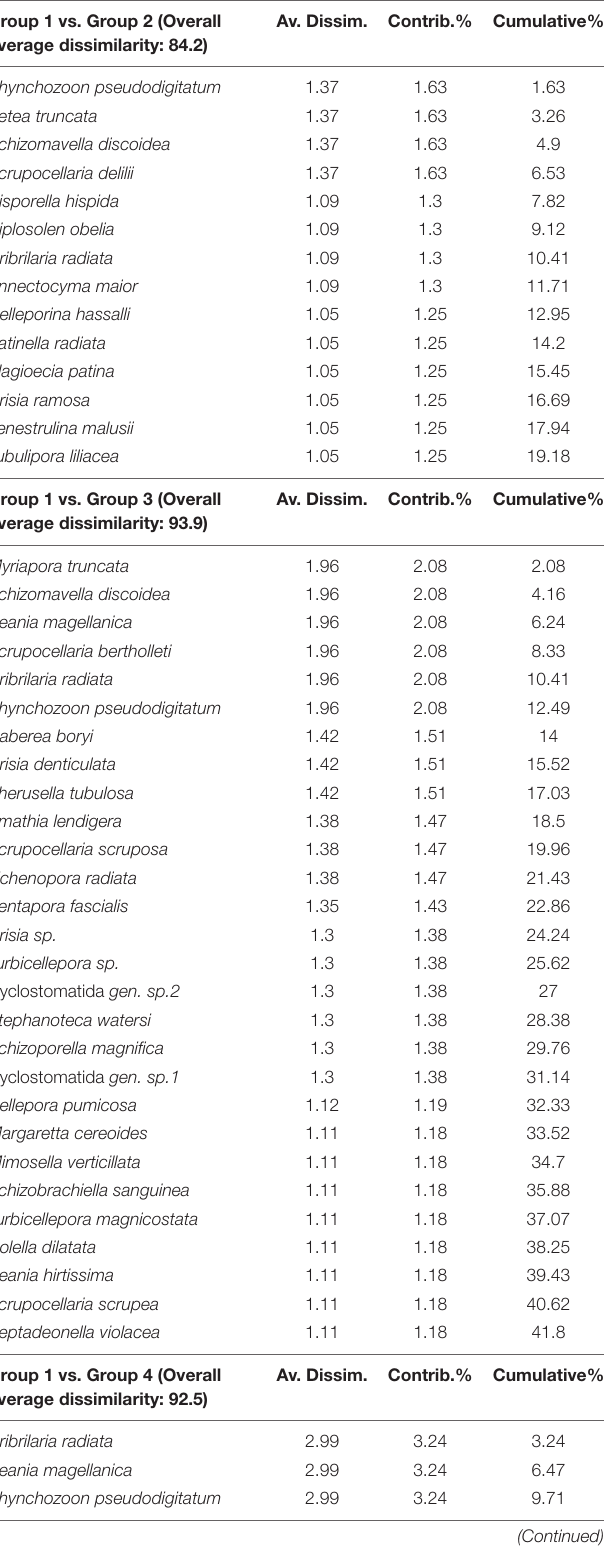
TABLE 4 | List of the top discriminating species with contribution of more than 1% by SIMPER analysis for the four main clusters extrapolated by the cluster analysis and confirmed by the analysis of similarities (ANOSIM)